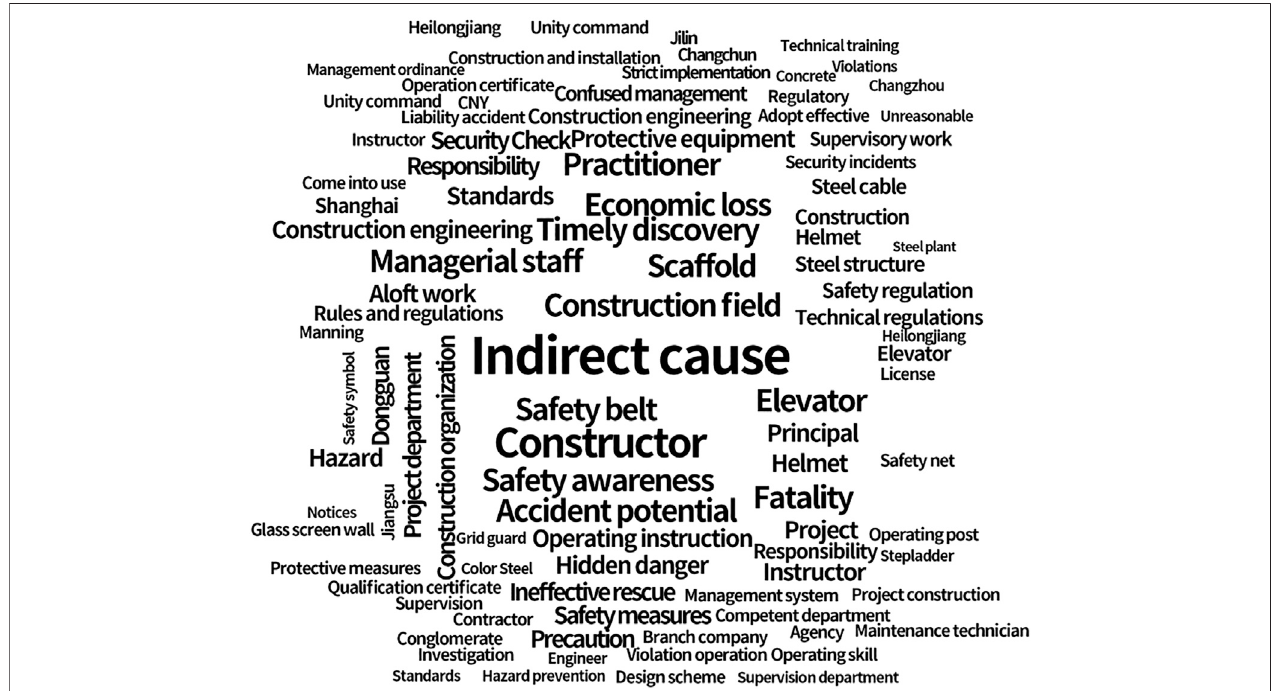
FIGURE 2 | Word segmentation results of the construction site fall accident reports.